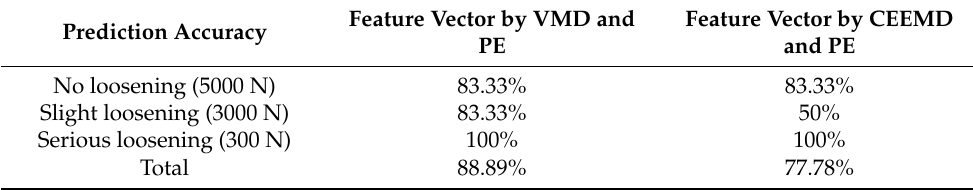
Table 3. Prediction accuracy under the conditions of variable-amplitude pulse load.